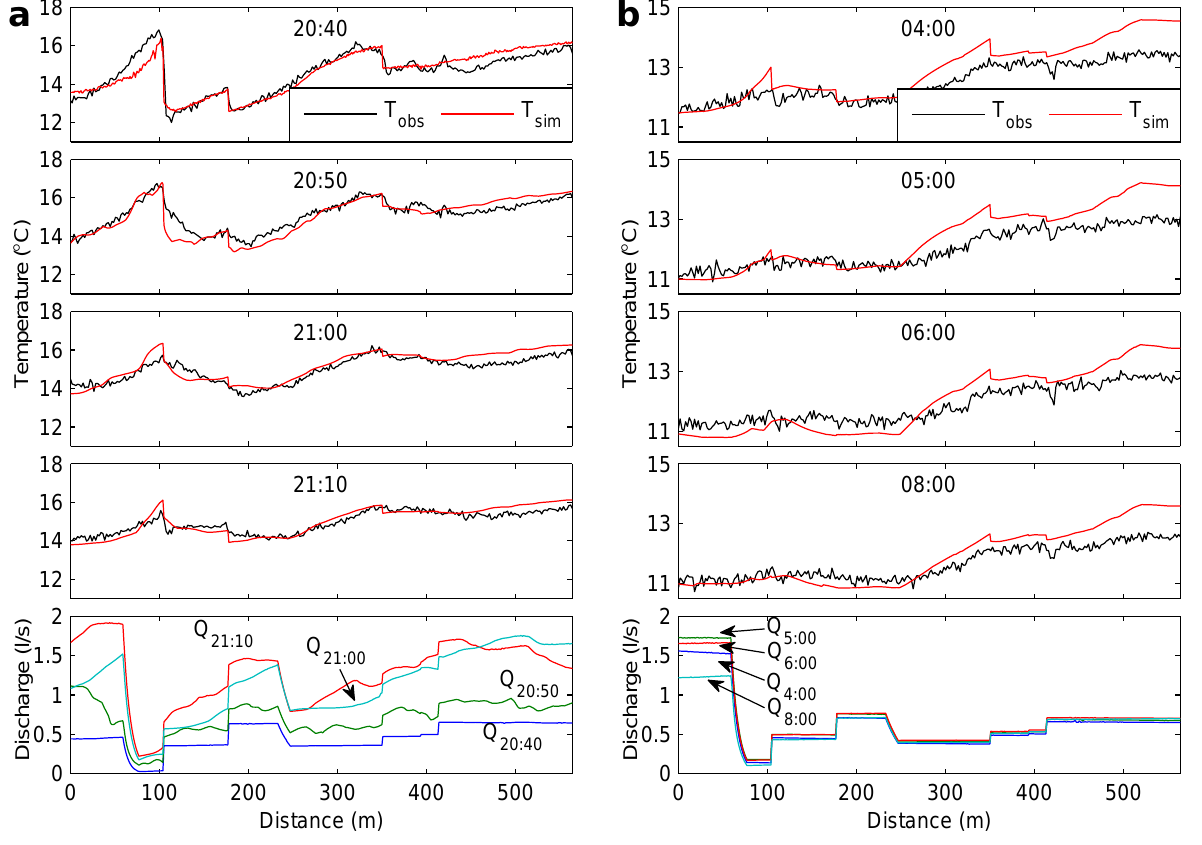
Fig. 5. Observed and simulated temperature and simulated discharge during (a) first discharge peak (after calibration) and (b) second discharge peak using the same parameters as during the first discharge peak. q hyp and A hz are variable over